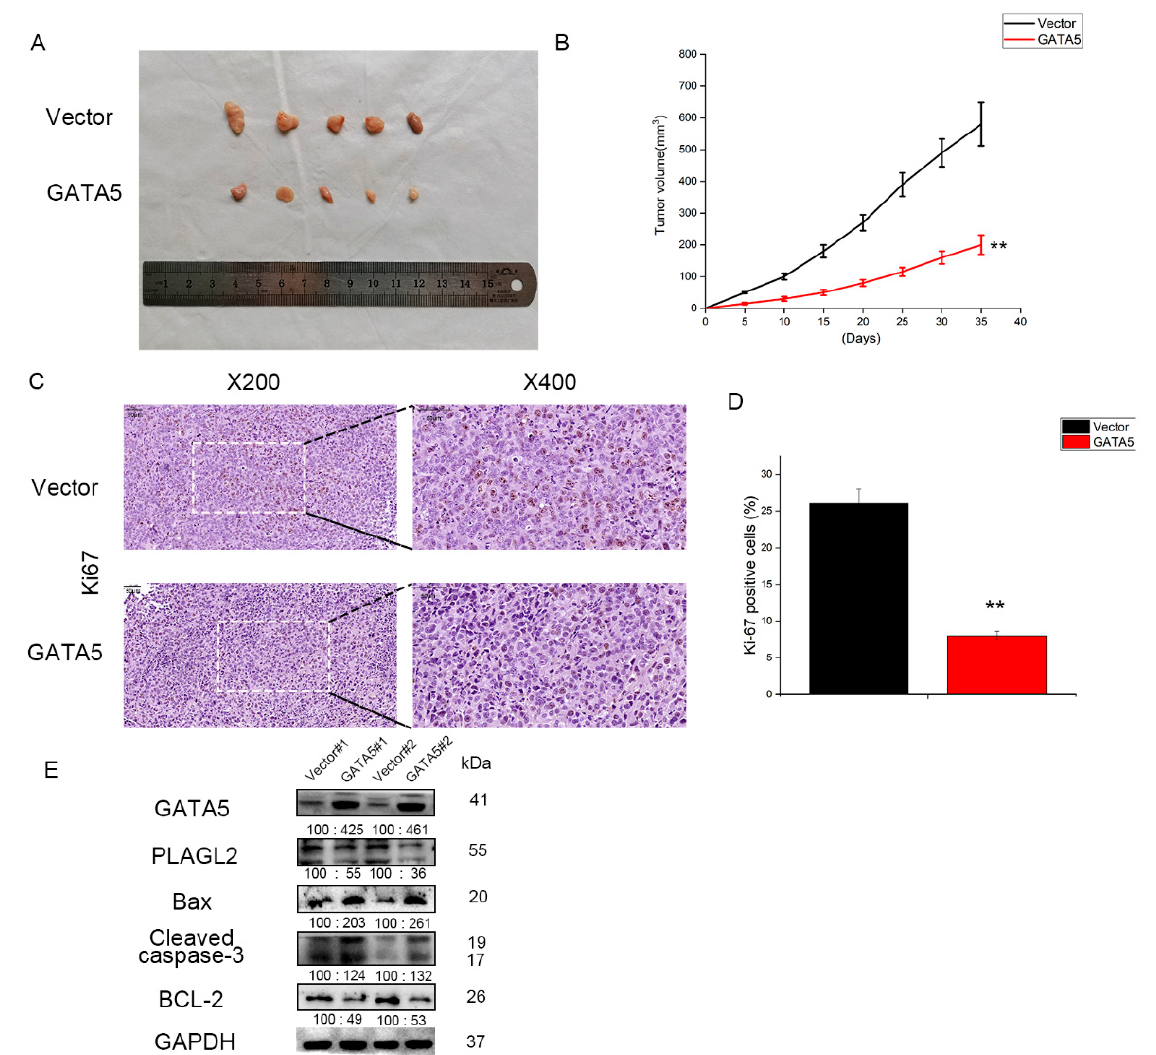
Figure 5. GATA5 overexpression suppresses PCa cell growth in vivo. ( A ) The tumor models in the pc-GATA5 group were much smaller when compared with the pc-vector group. ( B ) The tumors volume at each specific time point was calculated, and the results demonstrated that both the tumor growth rate and size in the pc-GATA5 group were smaller than those in the pc-vector group. ( C , D ) Immunohistochemistry was implemented to assess the expression of Ki67 in tumors. ( E ) Overexpression of GATA5 promoted prostate cancer cell apoptosis in vivo. Data are presented as mean ± SD of at least three experiments. ** p < 0.01.